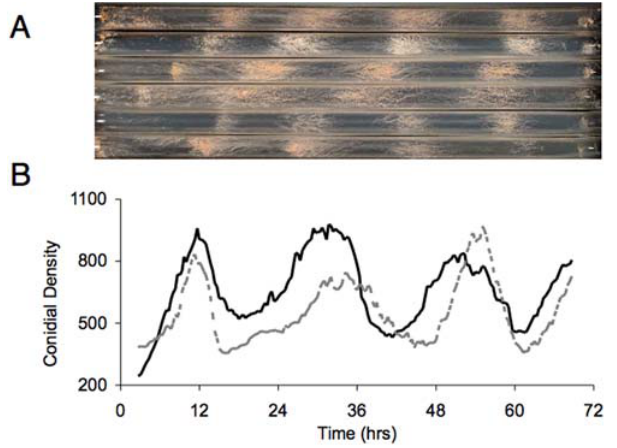
Figure 1. Phenotypic variation in pigmentation, period and phase in N. crassa conidiation revealed by inverted race tube assay. Representative accessions are shown to highlight variation in pigmen- tation (A), period and phase (B). The accessions in A are, from top to bottom, FGSC # 4833, FGSC # 852, FGSC # 4829, FGSC # 5914, FGSC # 4817 and FGSC # 4723. Conidial density in B was estimated using the Chrono program and plotted as a line graph for visual effect. The accessions in B are FGSC # 6634 (black) and FGSC # 3968 (grey). Accessions were grown at 25 u C and represent one replicate to highlight circadian regulated conidiation